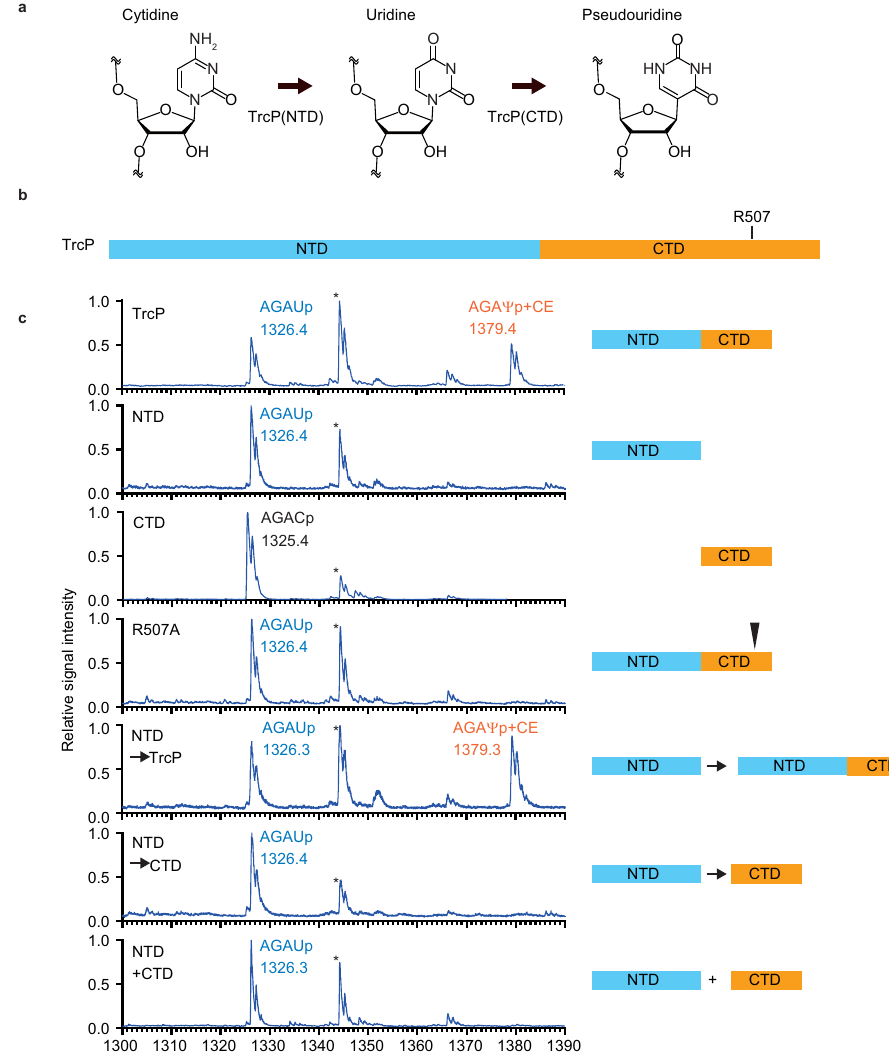
Ψ .RNaseAdigestsofacyanoethylatedRNAfragmentweresubjectedtoMS.Them/ z values and assigned fragments are shown. Asterisks indicate the fragment cor- responding to the tetramer fragment, GAGDp (m/z 1344) derived from positions 13 –